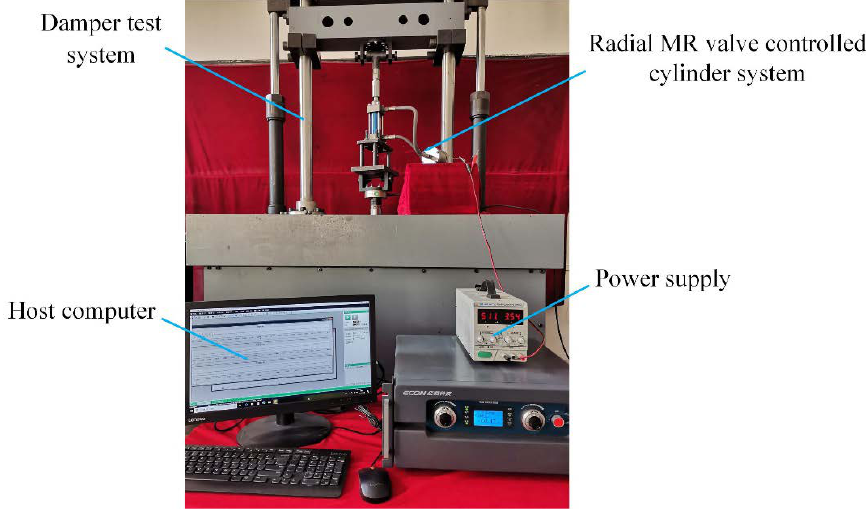
Figure 27. Experimental test rig of the optimal radial MR valve controlled cylinder system.